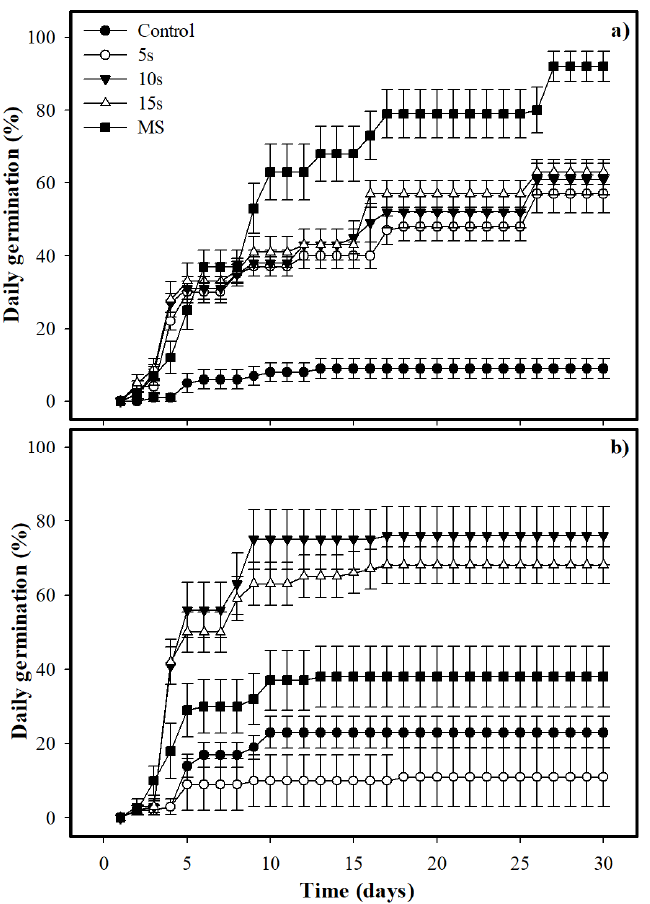
Figure 2. Daily seed germination (mean ± standard error, n = 10) in ( a ) Enterolobium cyclocarpum and ( b ) Piscidia piscipula in different germinative pre-treatment (boiling water for 5 s, 10 s and 15 s and MS = mechanical scarification).